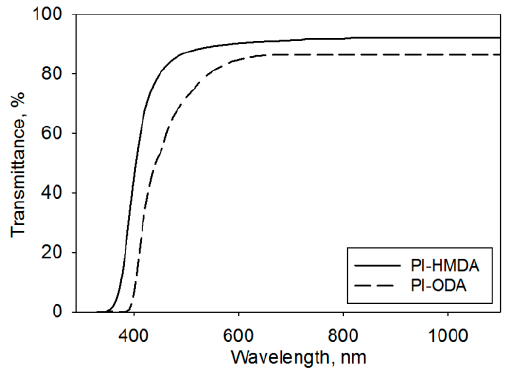
Figure 2. The transmittance data against wavelength recorded for PI-HMDA and PI-ODA free-standing films. standing